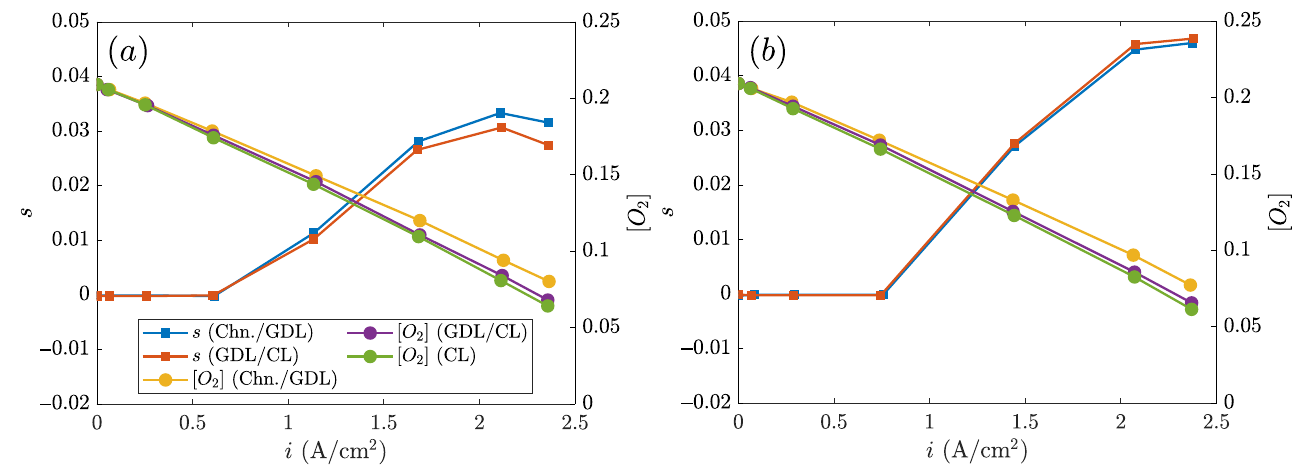
Figure 6. Liquid saturation s and oxygen mass fraction [ O 2 ] vs. current density in the cathode: ( a ) SIGRACET 34BA (no MPL), ( b ) AvCarb P-75 without